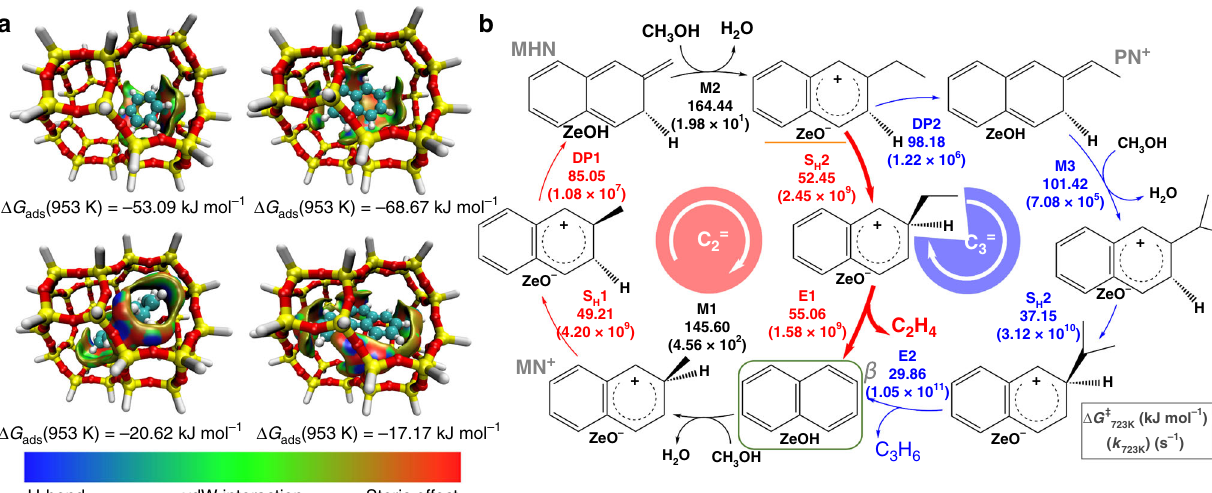
Fig. 2 Guidance from density functional theory to screen the stable and functional intermediates. a Isosurface plots of the reduced density gradient and Gibbs free energy of adsorption at 953 K for the benzenic, naphthalenic, phenanthrenic, and pyrenic carbenium ions con fi ned in neutral pure silica model of CHA cavity. The isosurfaces of the reduced density gradient are colored according to the values of the quantity sign( λ 2 ) ρ with the indicated RGB scale. vdW represents the van der Waals interactions. b Proposed side-chain mechanism in SAPO-34 zeolite for ethylene (C 2 = ) and propylene (C 3 = ) formation starting from sterically stabilized naphthalene. Gibbs free energy in kJ mol − 1 and intrinsic rate coef fi cient in 1 s − 1 (in parentheses) at 723